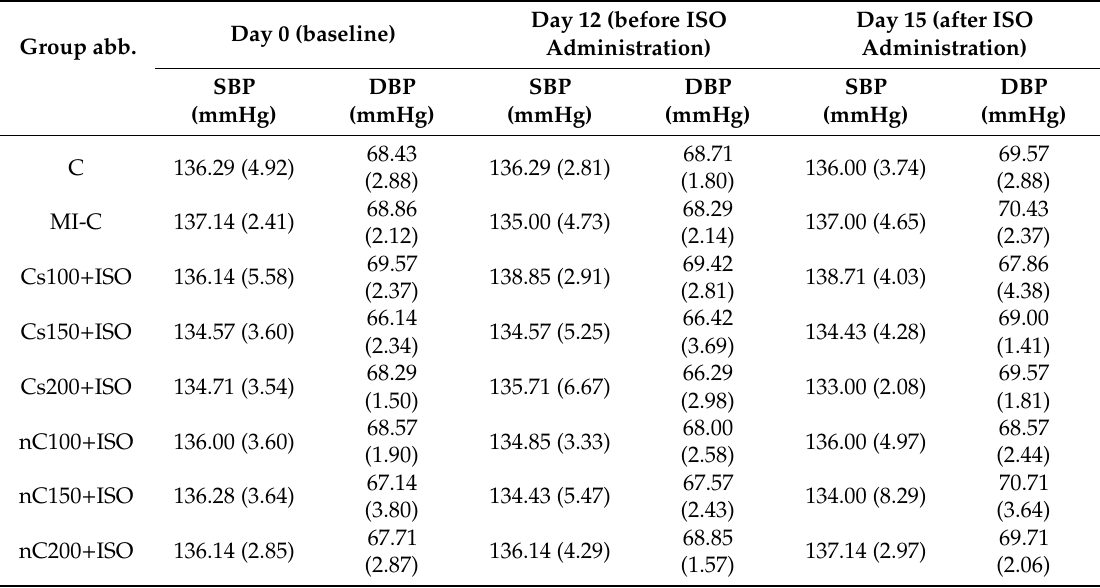
Table 1. Dynamic evolution of systolic and diastolic blood pressure from baseline to 15 days follow-up. Group abb.